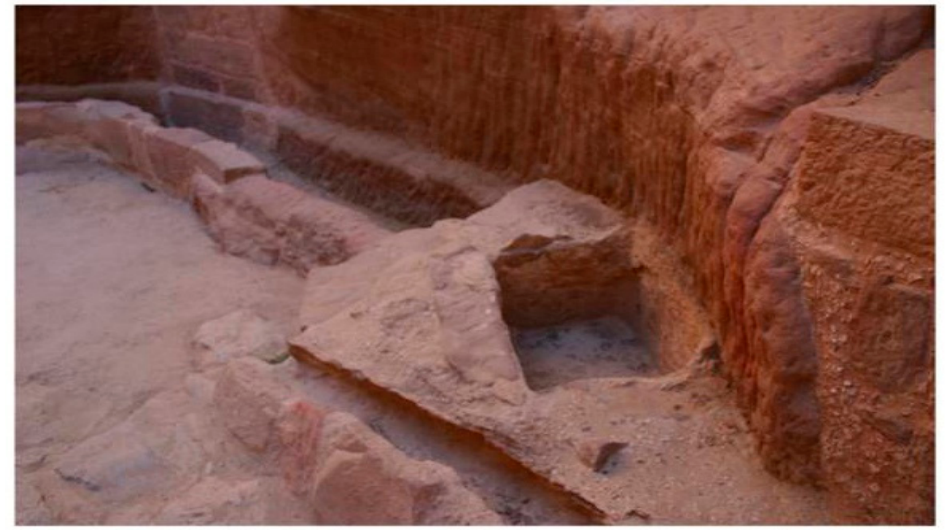
Figure 6. Typical open basin between segments of the Siq pipeline.